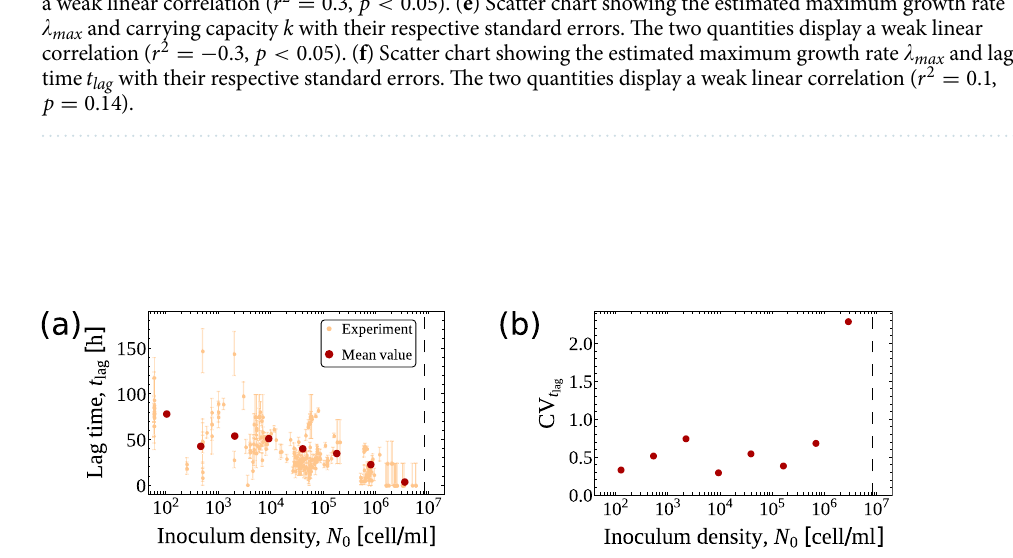
Figure 2. ( a ) Lag time t lag as a function of the inoculum density N 0 . Orange markers represent results from individual experiments together with their standard errors. Red markers denote the behaviour of the mean lag time. The dashed black line corresponds to the empirical mean carrying capacity. ( b ) Empirical behaviour of the coefficient of variation of the lag time ( CV t ) as a function of the initial density N 0 lag